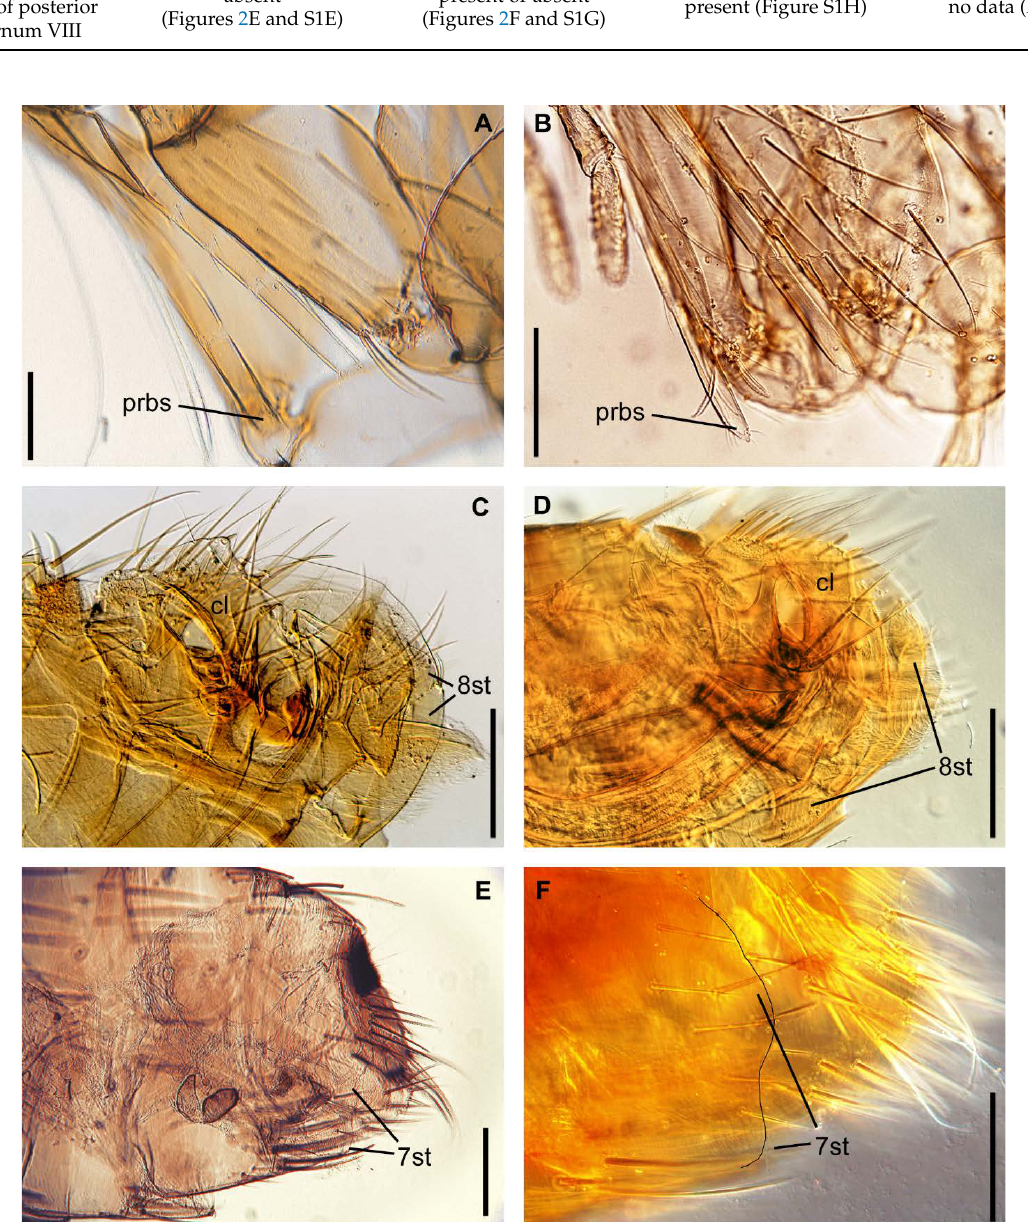
Figure 2. Diagnostic characteristics of Citellophilus tesquorum subspecies. Head: ratio of proboscis (prbs) apex to coxa of ( A ) C. t. altaicus and ( B ) C. t. sungaris . Abdomen: clasper (cl) and sternum VIII (8st) of ( C ) C. t. altaicus and ( D ) C. t. sungaris . Abdomen: outline of sternum VII (7st) of ( E ) C. t. altaicus and ( F ) C. t. sungaris . Scale bars = 0.1 mm.